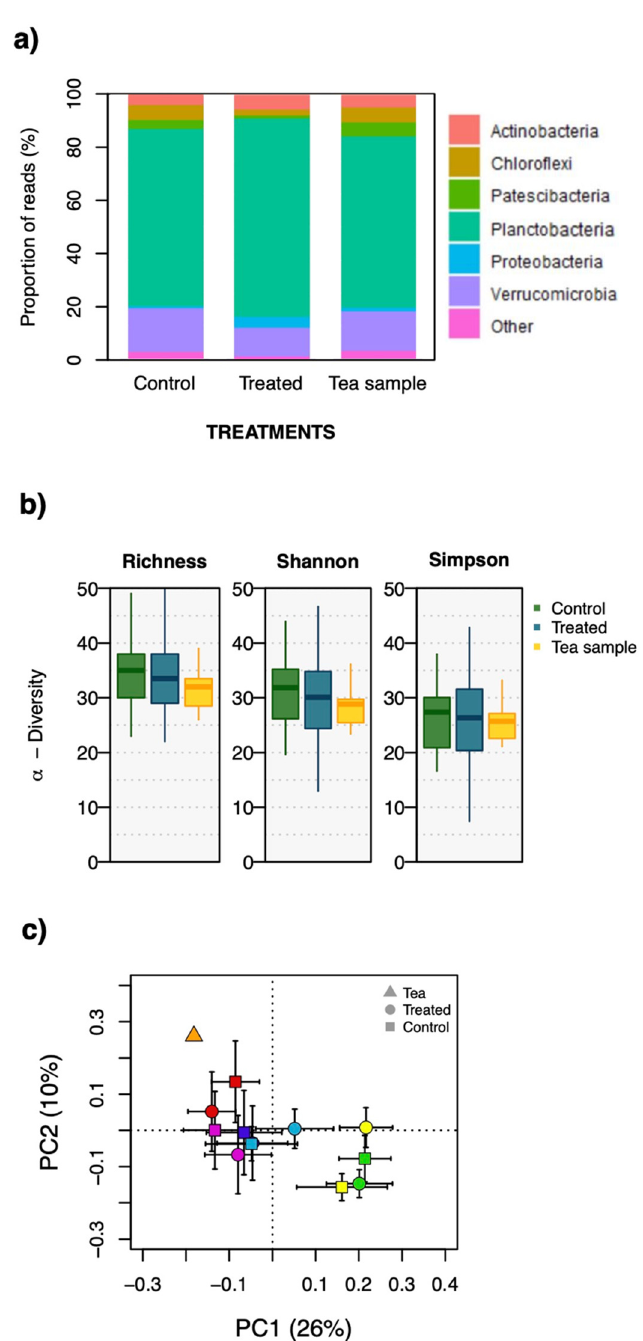
Figure 1. ( a ) relative abundance of ASVs belong to the different bacterial phyla present in soils treated with living compost tea (“Treated”), with sterilized compost tea (“Control”) or from tea samples taken prior to application (“Tea sample”). ( b ) alpha-diversity of bacterial communities (exponential Shannon ( eH ) and inverse Simpson indices). ( c ) principal component analysis (PCA) of Hellinger-transformed bacterial relative abundances. Bacterial communities tend to cluster according to experimental blocks (yellow, green, dark-blue, light-blue, pink and red, represent six experimental blocks; orange triangle represents compost tea). Shapes (circle and square) represent treatments. Symbols represent the mean scores of samples from a given plot, and error bars represent 95% confidence intervals.